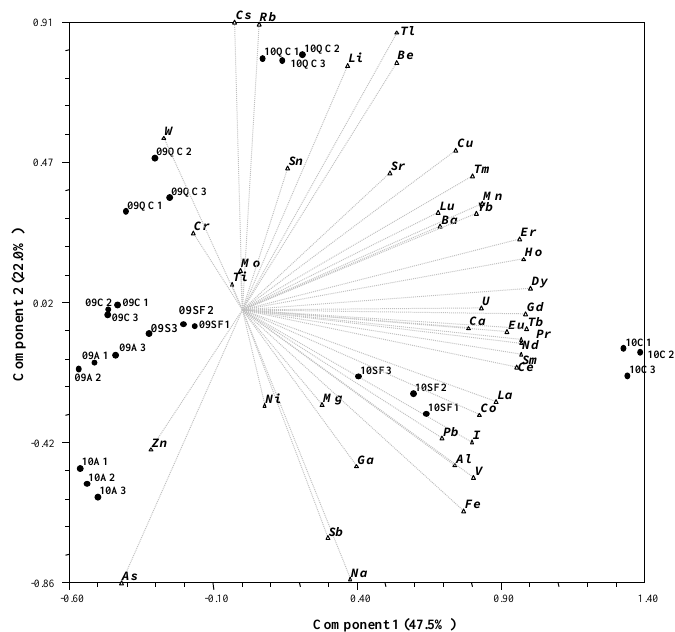
Figure 7. Principal Component Analysis performed on elemental wine composition (2009 and 2010 vintages) from the vineyards/DO: (AL) Vinha de Algeruz/Palmela, (SF) Quinta de S. Francisco/Ó bidos, (SA) Quinta do Sanguinhal/Ó bidos, and (QC) Quinta dos Carvalhais/Dão, collected at the final step of the vinification processes (5), in triplicate (1, 2, 3). Wines are represented in the plane of the two first components which express, respectively, 47.5% and 22.0% of the total variance.